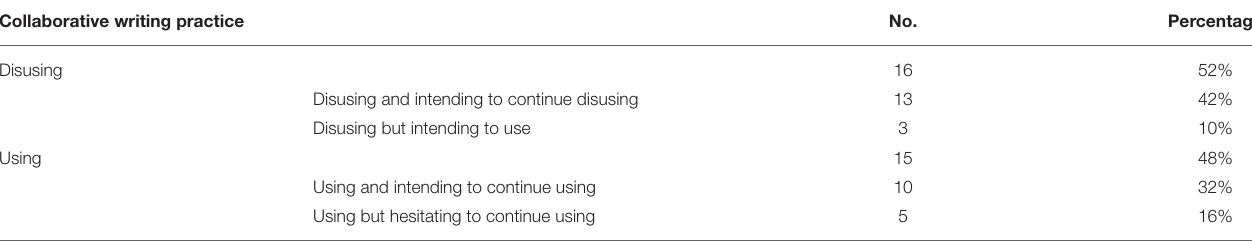
TABLE 2 | Summary of collaborative writing practice. Collaborative writing